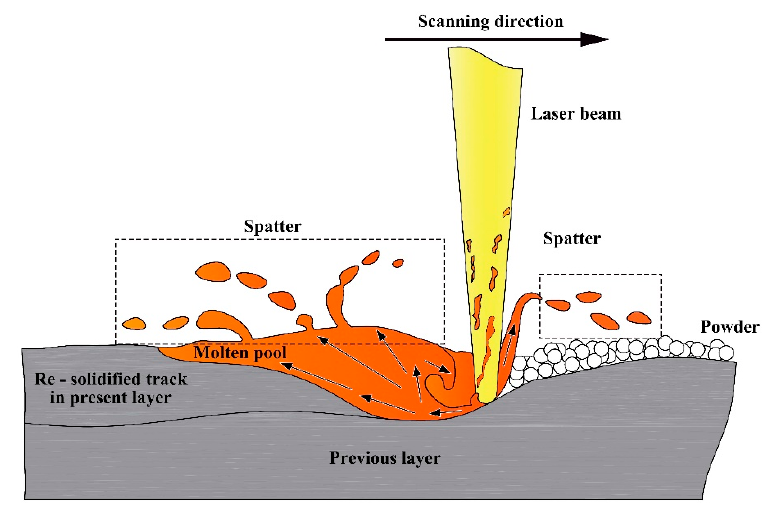
Figure 11. Spatter generation mechanism when laser interact with powder in SLM process.